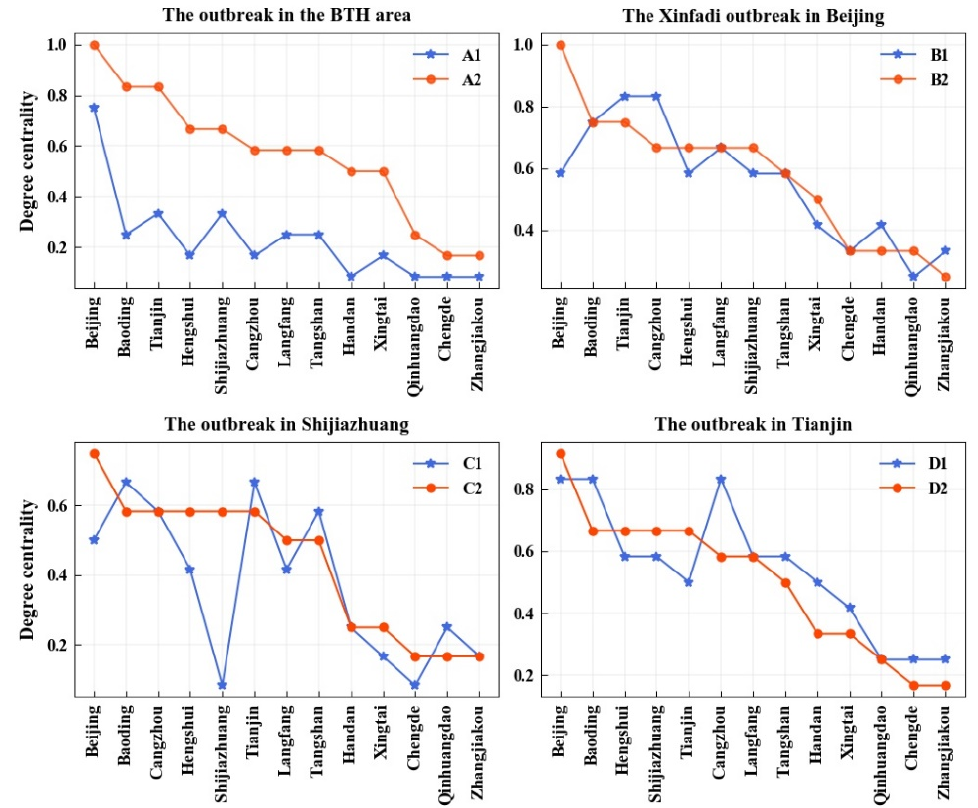
Figure 6. Changes in urban degree centrality in different periods.